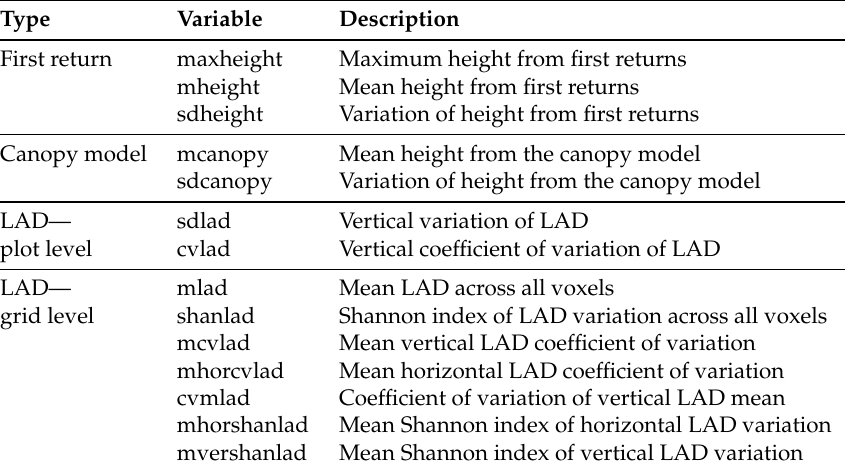
Table 2. Description of the lidar-based metrics of forest